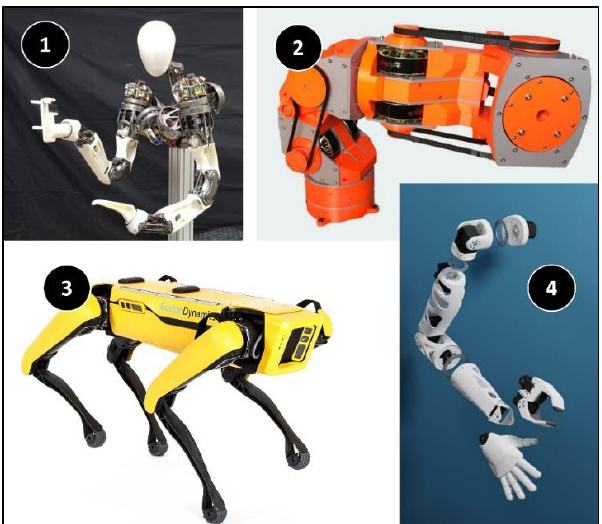
Figure 1. Examples of Robotic Limbs, from top left to bottom right, the LIMS-2 Ambidex (1), the Skyentific arm (2), Spot (3) and Reachy (4),